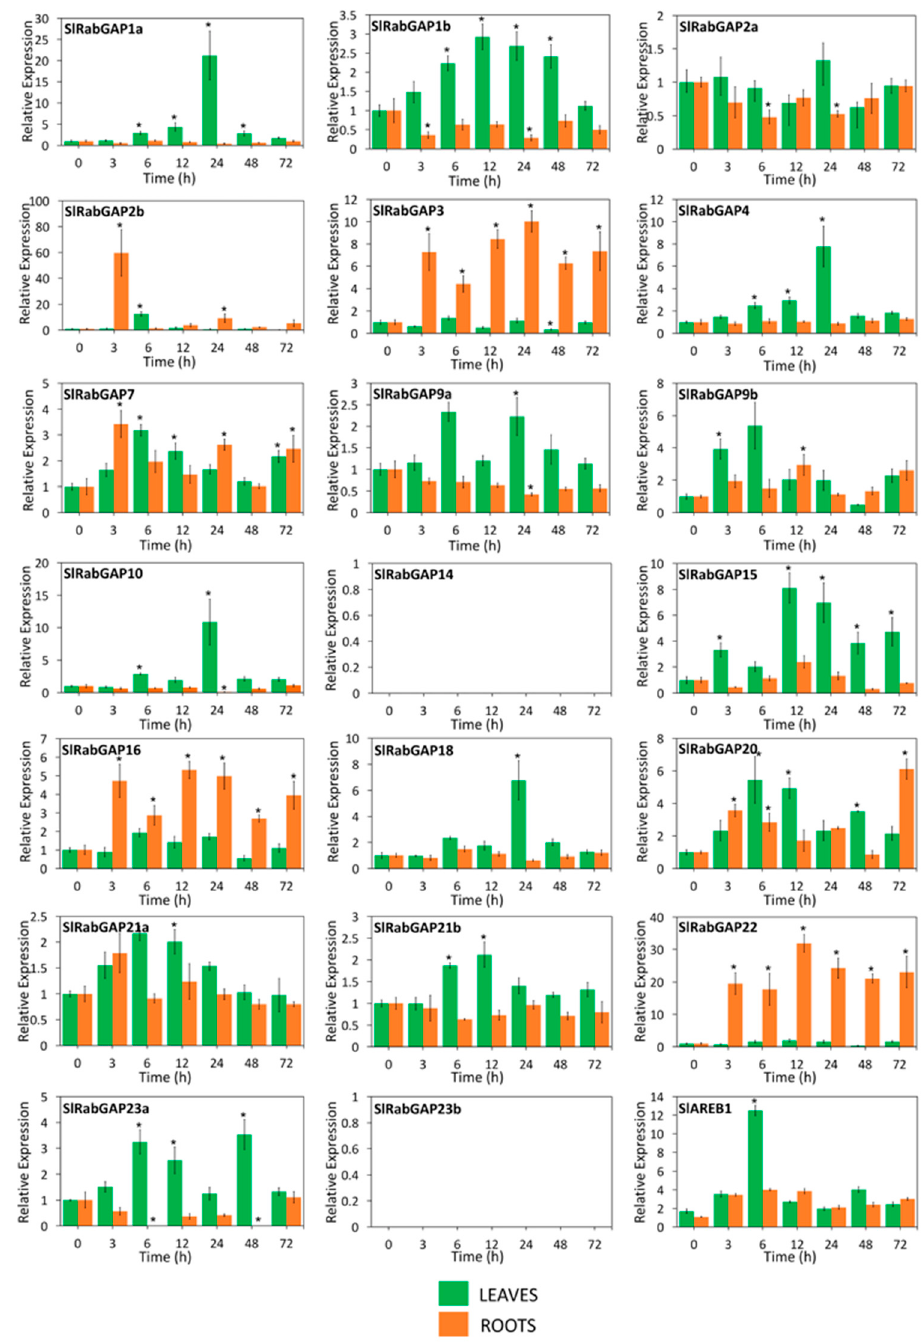
Figure 8. Spatio-temporal expression patterns of RabGAP genes of S. lycopersicum exposed to salt stress. Relative levels of SlRabGAP gene transcripts in roots (orange bar) and leaves (green bar) of 10–12-week-old S. lycopersicum plants were determined at 0, 3, 6, 12, 24, 48, and 72 h after stress initiation with 300 mM NaCl. The relative levels of the salt-stress marker gene ( SlAREB1 ) were measured. In SlRabGAP14 and -23b, transcripts were not detected. Columns and error bars represent the mean and standard deviation for three biological and three technical replicates. * p -value < 0.05.